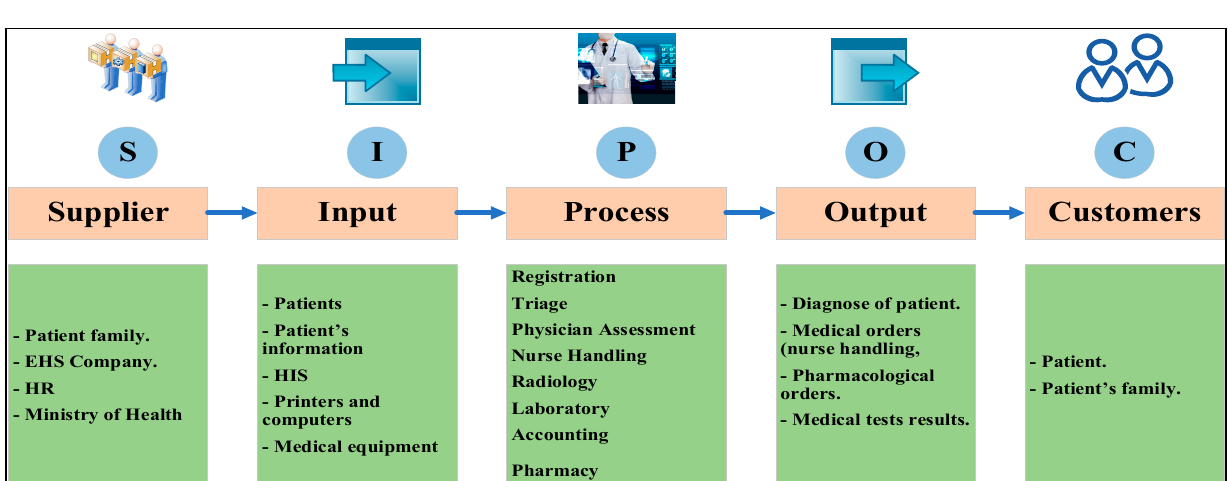
Table 4. Number of patients who came to PRPH’s emergency department with their acuity level index. Acuity Level Index